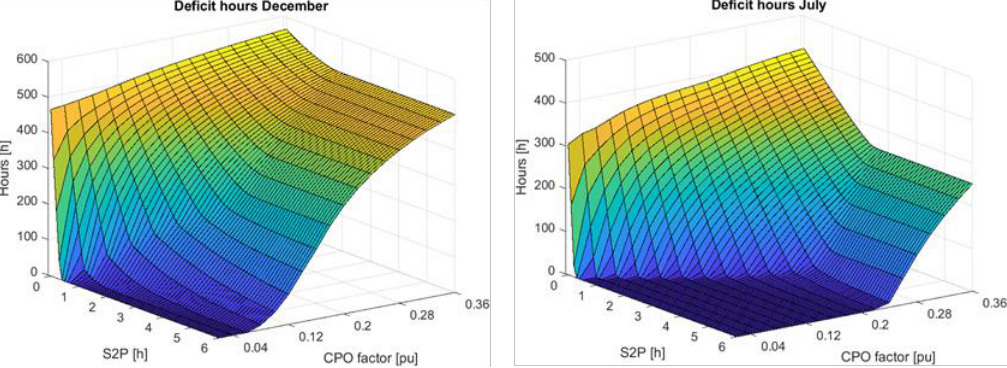
Figure 12. Average monthly hours with non-compliance with constant power in December and July.